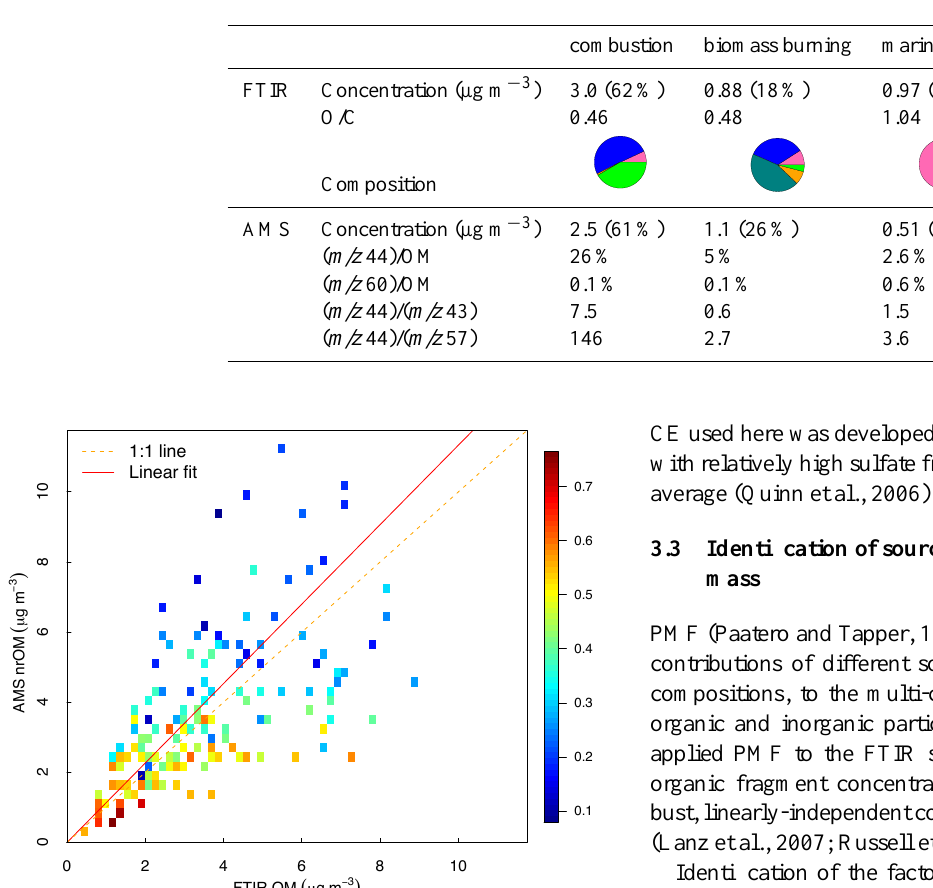
Table 2. Concentration and composition of PMF factors identified from the FTIR and the AMS measurements. Colors in the pie charts indicate alkane (blue), carboxylic acid (green), hydroxyl (hot pink), amine (orange), and non-acid carbonyl (teal) functional groups. Mass fractions of the factors are shown in the parentheses.